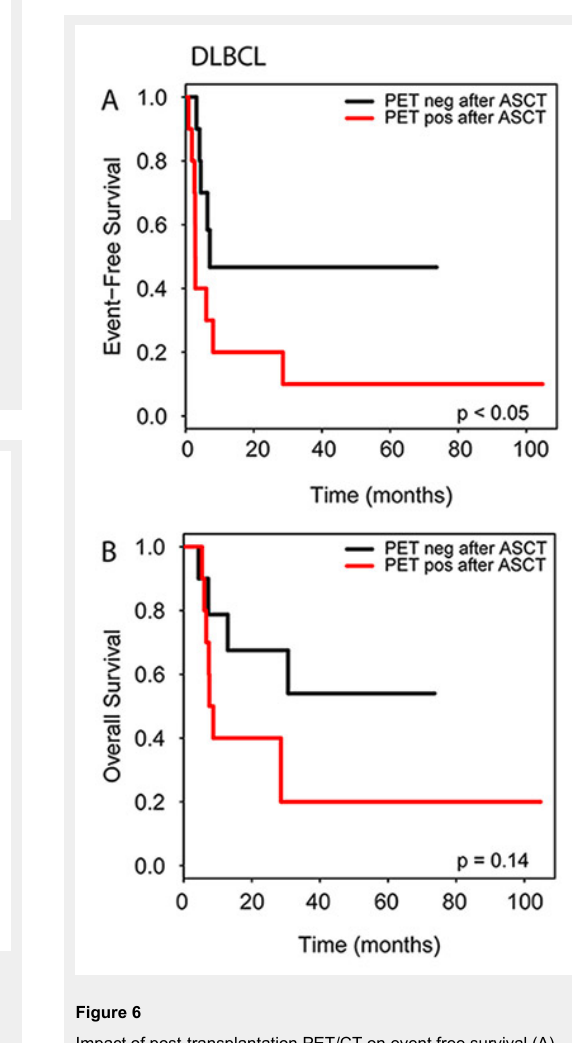
Impact of post-transplantation PET/CT on event free survival (A) and overall survival (B) in DLBCL patients.